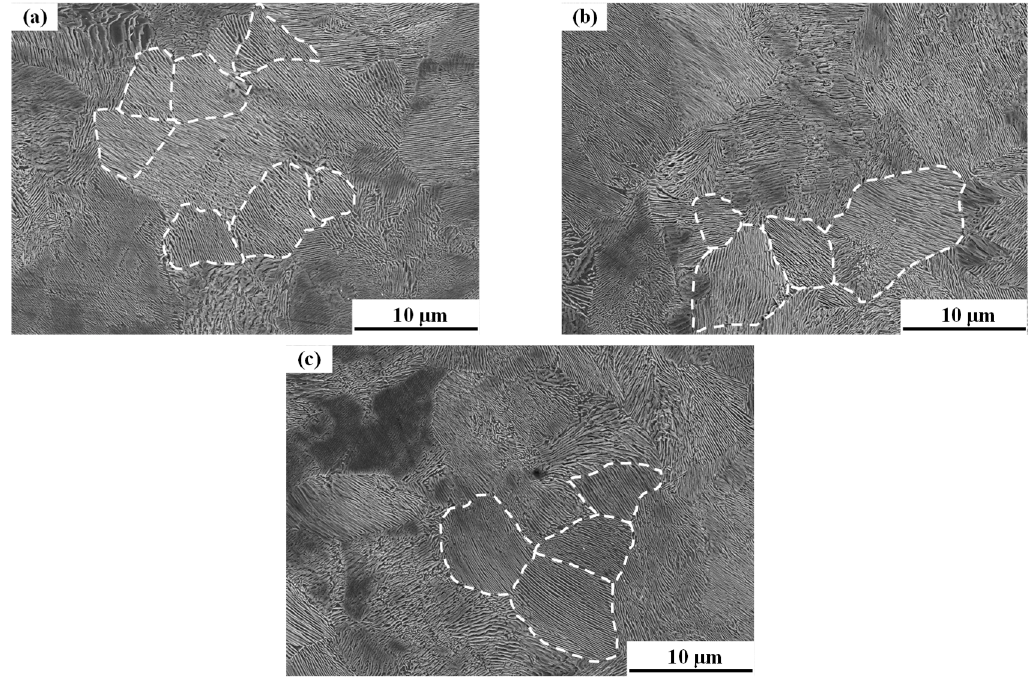
Figure 3. Scanning electron microscopy (SEM) micrograph of pearlite structure at different austenitizing temperatures: ( a ) 880 °C; ( b ) 1020 °C; and ( c ) 1200 °C.